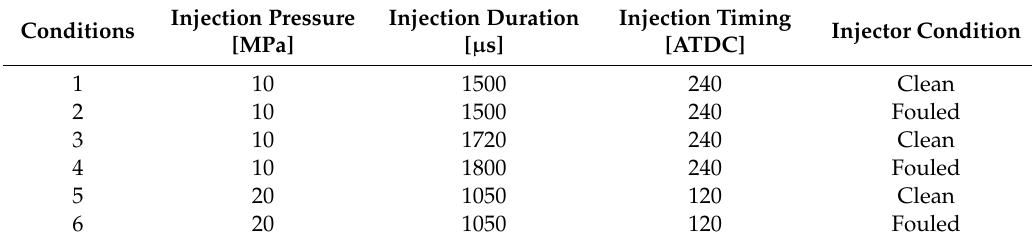
Table 2. Experiment operating conditions.